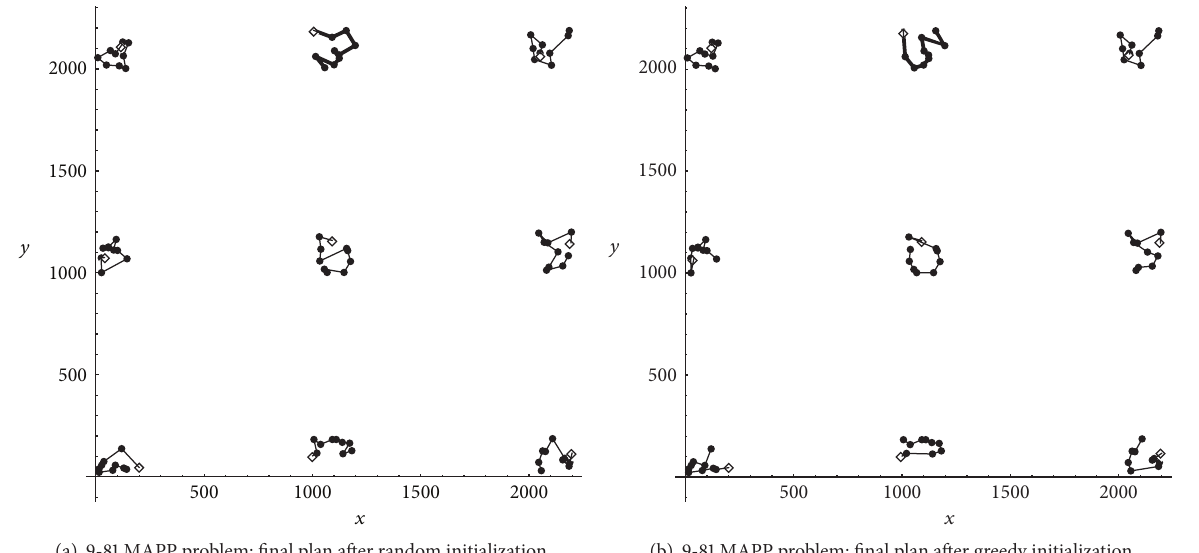
Figure 5: The GAID algorithm found 9 subtours which connect targets belonging to the same cluster for the 9-81 MAPP with both initialization strategies. The final costs are 612.3 and 594.1 , respectively.